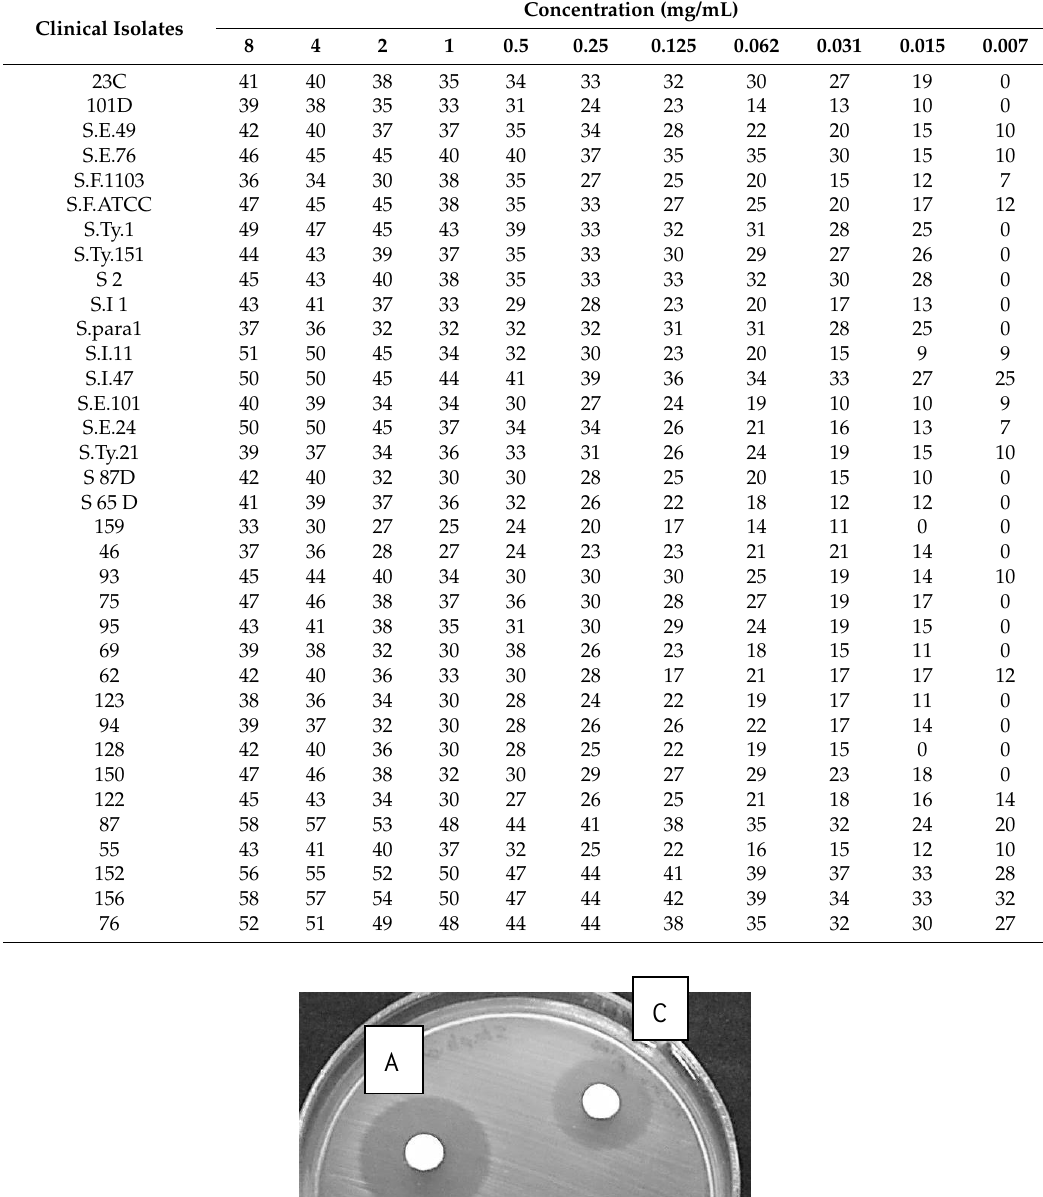
Table 1. Zone of inhibition(ZI) for the clinical strains of Salmonella (in mm).